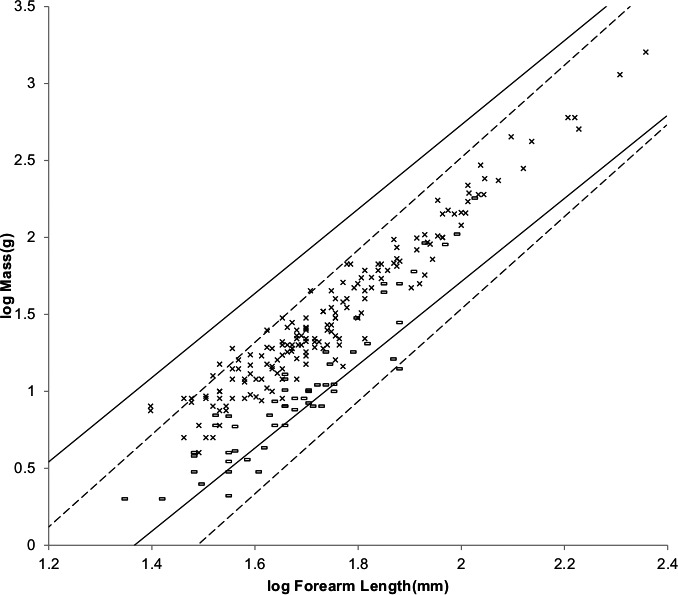
Log body mass as a function of log forearm length for heavy and light bats.The solid and dashed lines are the MMLE sturdiness factor boundaries. The upper boundaries were generated with a sturdiness factor s = (3)0.5. The lower boundaries were generated with s = (3)−0.5. The shallower sloping solid boundary lines are for heavy bat Strouhal dynamic similarity. The steeper sloping dashed boundary lines are for light bat geometric similarity. \documentclass[12pt]{minimal}
\usepackage{amsmath}
\usepackage{wasysym}
\usepackage{amsfonts}
\usepackage{amssymb}
\usepackage{amsbsy}
\usepackage{upgreek}
\usepackage{mathrsfs}
\setlength{\oddsidemargin}{-69pt}
\begin{document}
}{}${R}_{M}^{2}=1.0$\end{document}RM2=1.0 for heavy bats with respect to the Strouhal boundaries. \documentclass[12pt]{minimal}
\usepackage{amsmath}
\usepackage{wasysym}
\usepackage{amsfonts}
\usepackage{amssymb}
\usepackage{amsbsy}
\usepackage{upgreek}
\usepackage{mathrsfs}
\setlength{\oddsidemargin}{-69pt}
\begin{document}
}{}${R}_{M}^{2}=1.0$\end{document}RM2=1.0 for light bats with respect to the geometric boundaries. Individual heavy bats are marked with Xes. Individual light bats are marked with open rectangles.